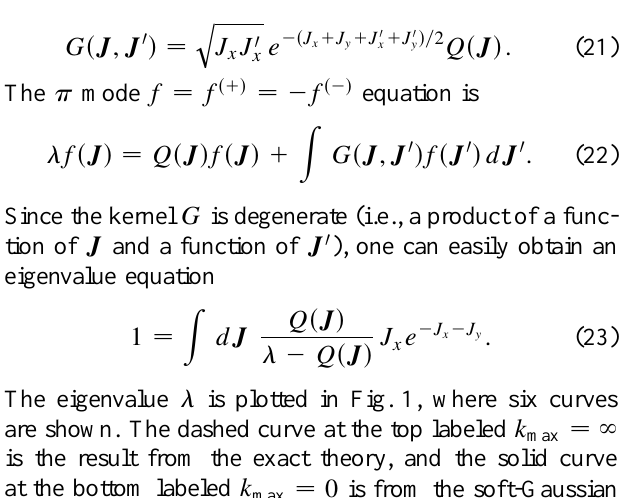
FIG. 1. (Color) p -mode eigenvalue as a function of the as- pect ratio. k max is the truncation of the Hermitian polynomial. k max (cid:1) 0 corresponds to the soft-Gaussian approximation and k max (cid:1) ` is the exact theory.